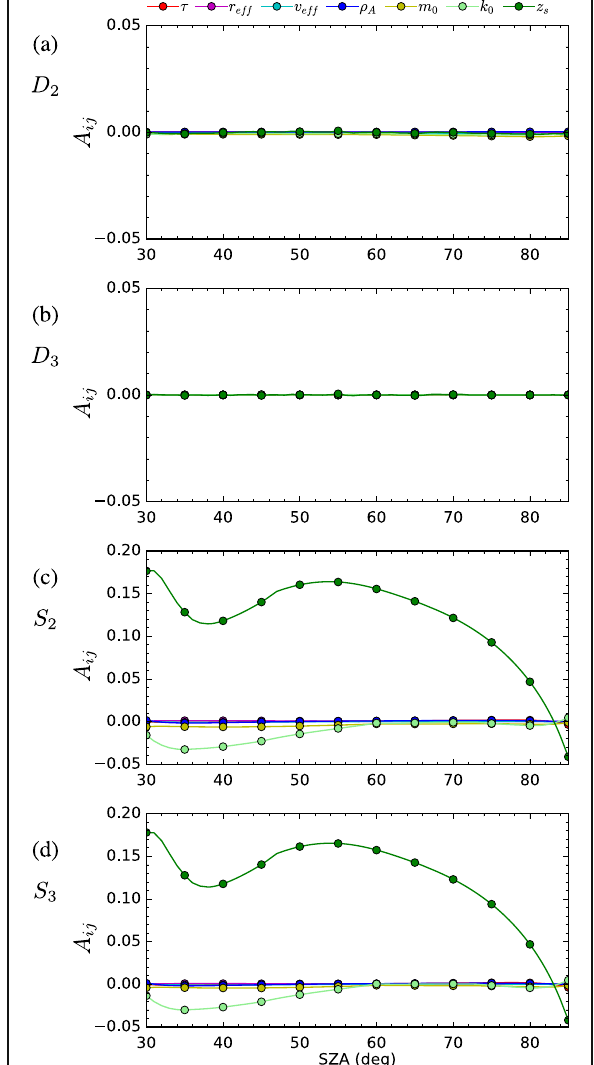
Fig. 15 Non-diagonal elements of AKM of TCWV. Panels ( a ) - ( d ) show the relation between A ij and SZA for D 2 , D 3 , S 2 , and S 3 ,